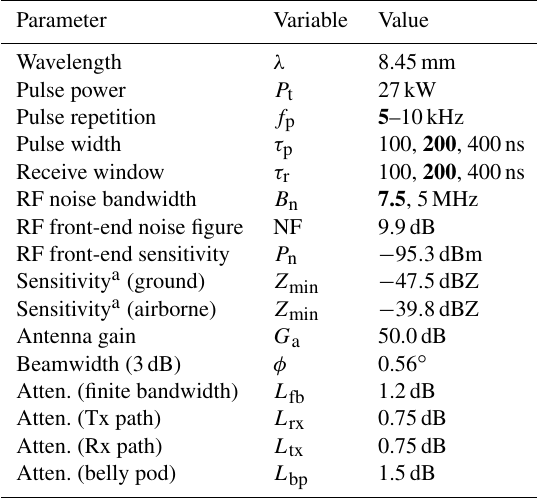
Table 1. Technical specifications of the HAMP cloud radar as char- acterized in this work. Boldface indicates the operational configu- ration used in this